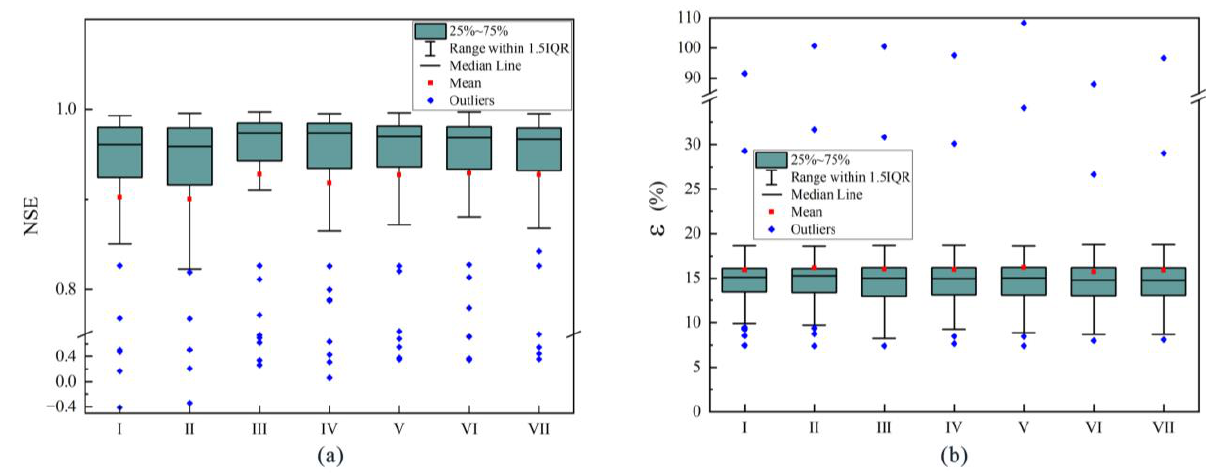
Figure 5. The box charts of ( a ) the NSE values and ( b ) the ε values of FDCs obtained by simulation for different combinations.